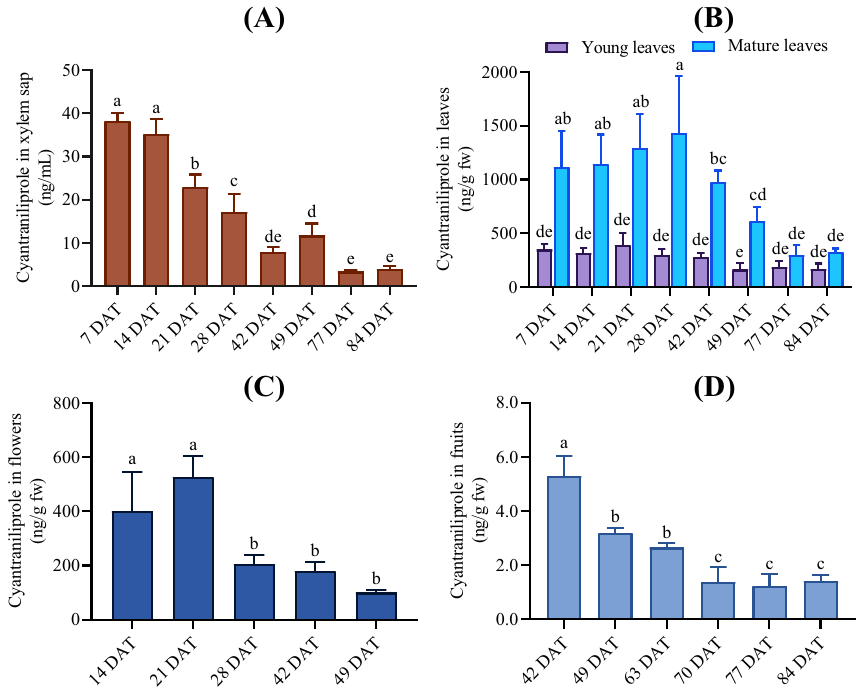
Figure 1. Concentrations of cyantraniliprole in xylem sap ( A ), leaves ( B ), flowers ( C ), and fruits ( D ) of tomato plants at different sampling times after treatment with Mainspring ® GNL. The values represent the means ± standard deviation ( n = 5). Columns within the same graph topped by different letters are significantly different from each other ( p <